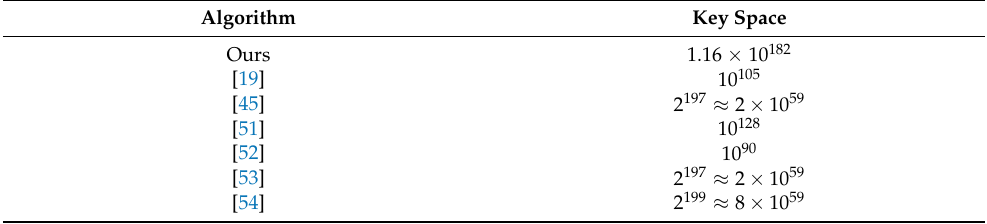
Table 1. Key space comparison between the proposed scheme and other schemes.